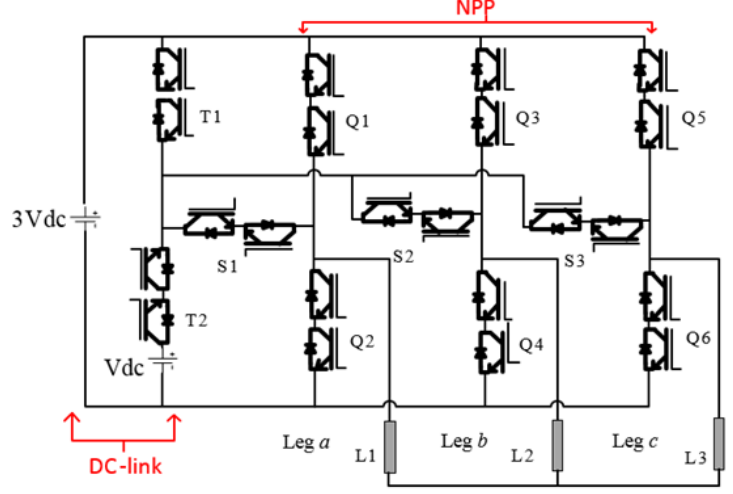
Figure 1. The proposed four-level T-type neutral point piloted (T-NPP) topology. Table 1. Switching state for the proposed topology for leg a.